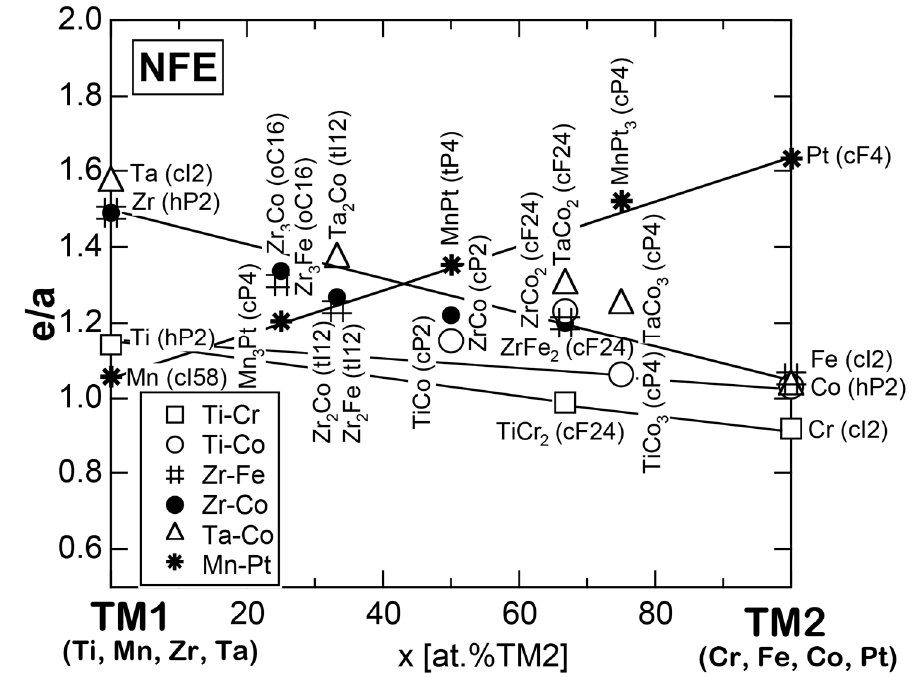
Figure 99. Composition dependence of e/a for intermetallic compounds and pure elements in TM1–TM2 (TM1 = Ti, Mn, Zr, Ta) and (TM2 = Cr, Fe, Co, Pt) alloy systems [37]. The NFE method is exclusively employed. The linear interpolation lines are drawn by connecting end points of pure elements in the respective alloy systems. Symbols in bracket refer to the Pearson symbol for elements and compounds.